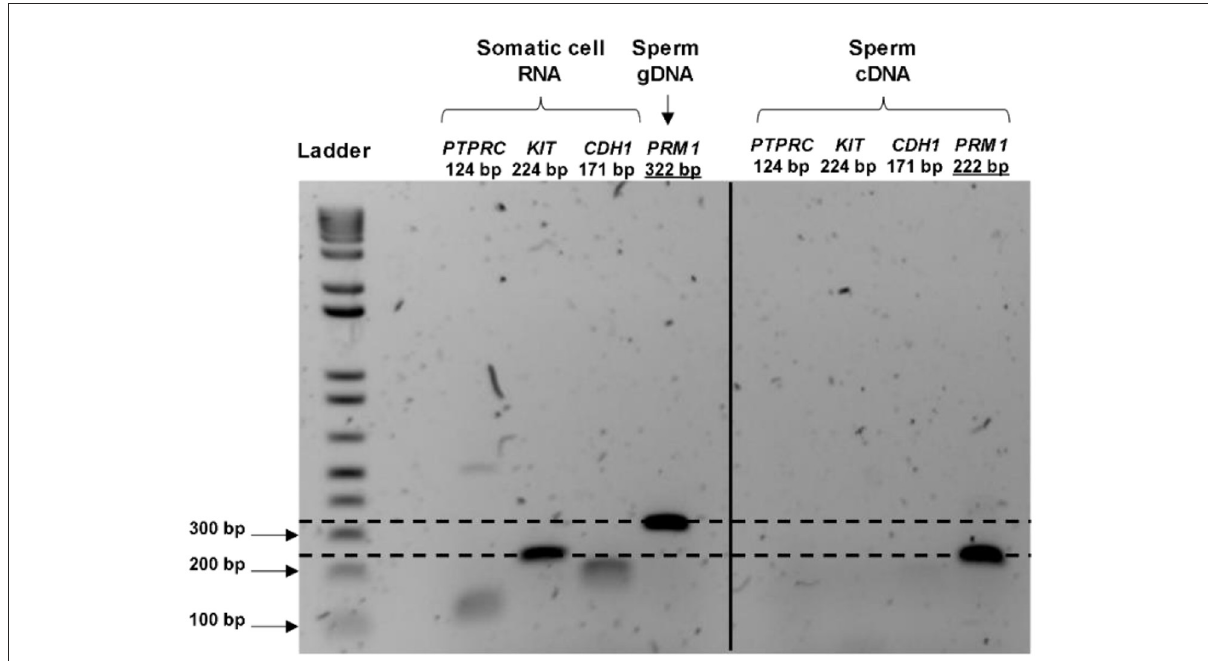
FIGURE1 RNA purity control and validation of the presence of transcripts in bull spermatozoa. The cDNA from the control (cow uterine RNA) amplifies all the primers at the expected product size, whereas the cDNA synthesized from the sperm RNA amplified only for the sperm-specific primer ( PRM1 ). PRM1 primers were designed to span a 100 bp intron; therefore, the gDNA signal appeared at 322 bp for the control (gDNA extracted from spermatozoa), whereas mRNA appeared at 222 bp. Overall, these indicated the purity of the sperm RNA from other contaminating cells and sperm genome